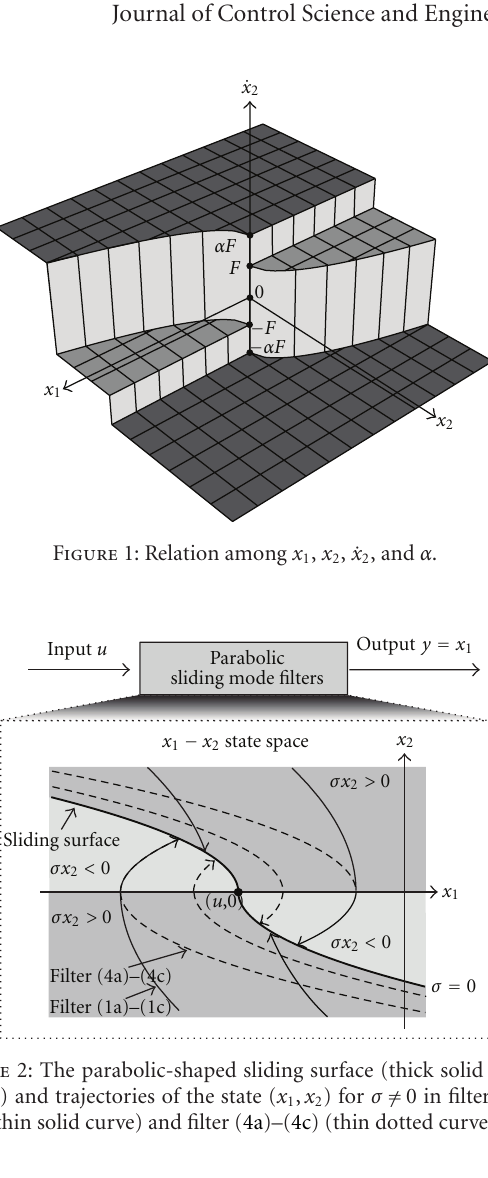
x σ / = 0 in filter (1a)– 1 , 2 ) for